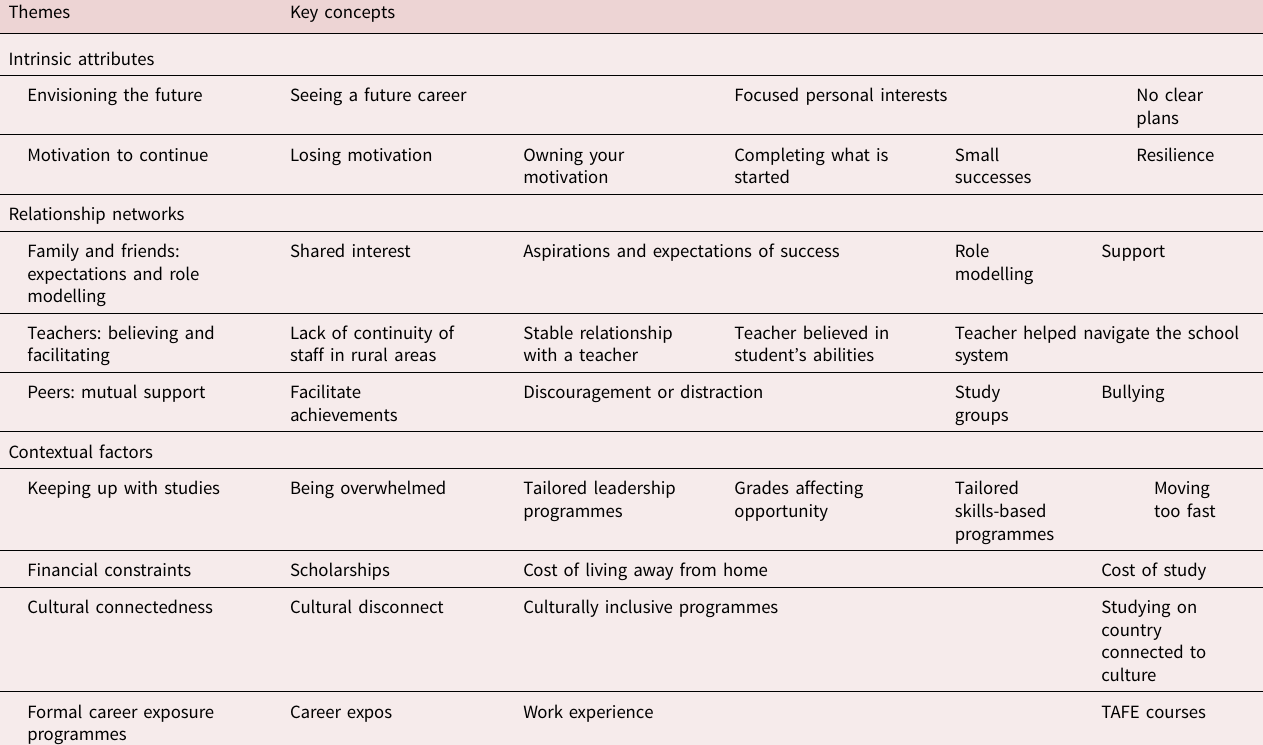
Table 2. Research themes and key concepts found in discourses with students